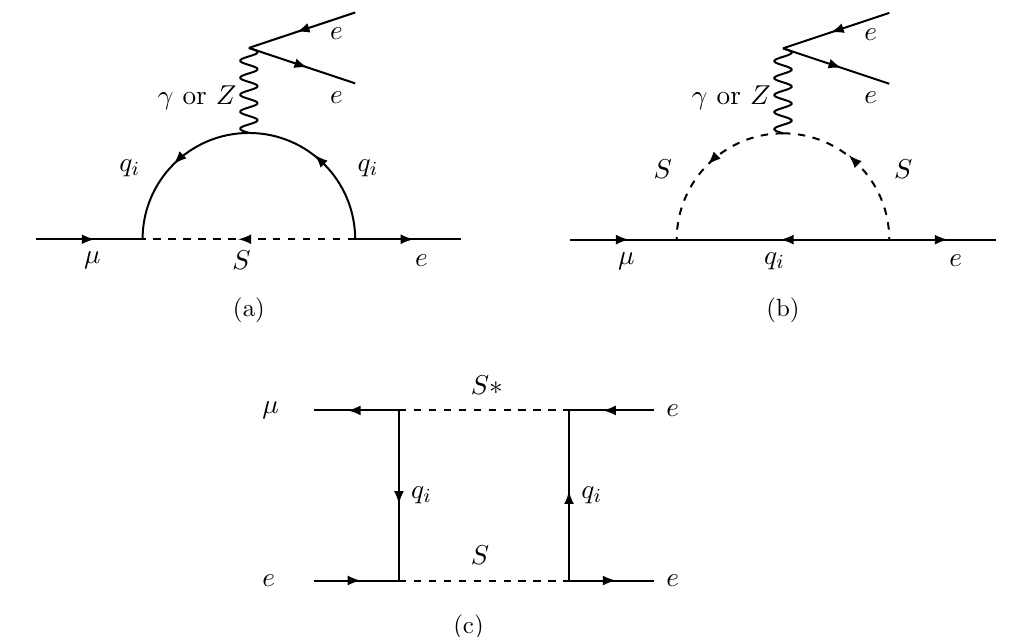
Figure 8 . There are three types of contributing diagrams to the (cid:22) ! eee process: two types of (cid:13) - and Z -penguin diagrams, and box Feynman diagrams. For our model, each penguin diagram could have either the S 4 = 3